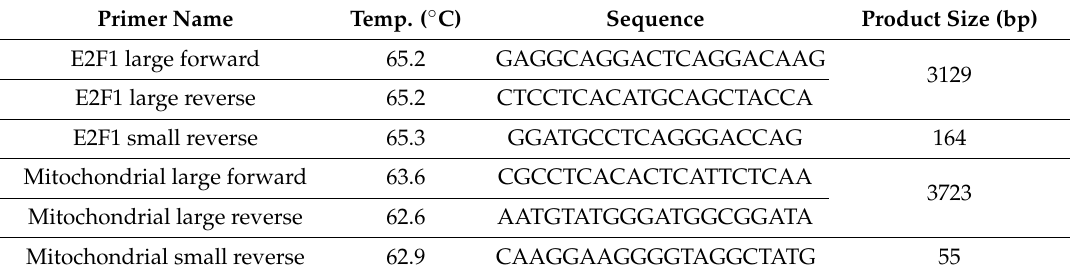
Table 1. Primers designed to amplify large and small products for E2F1 and the mitochondrial targets.